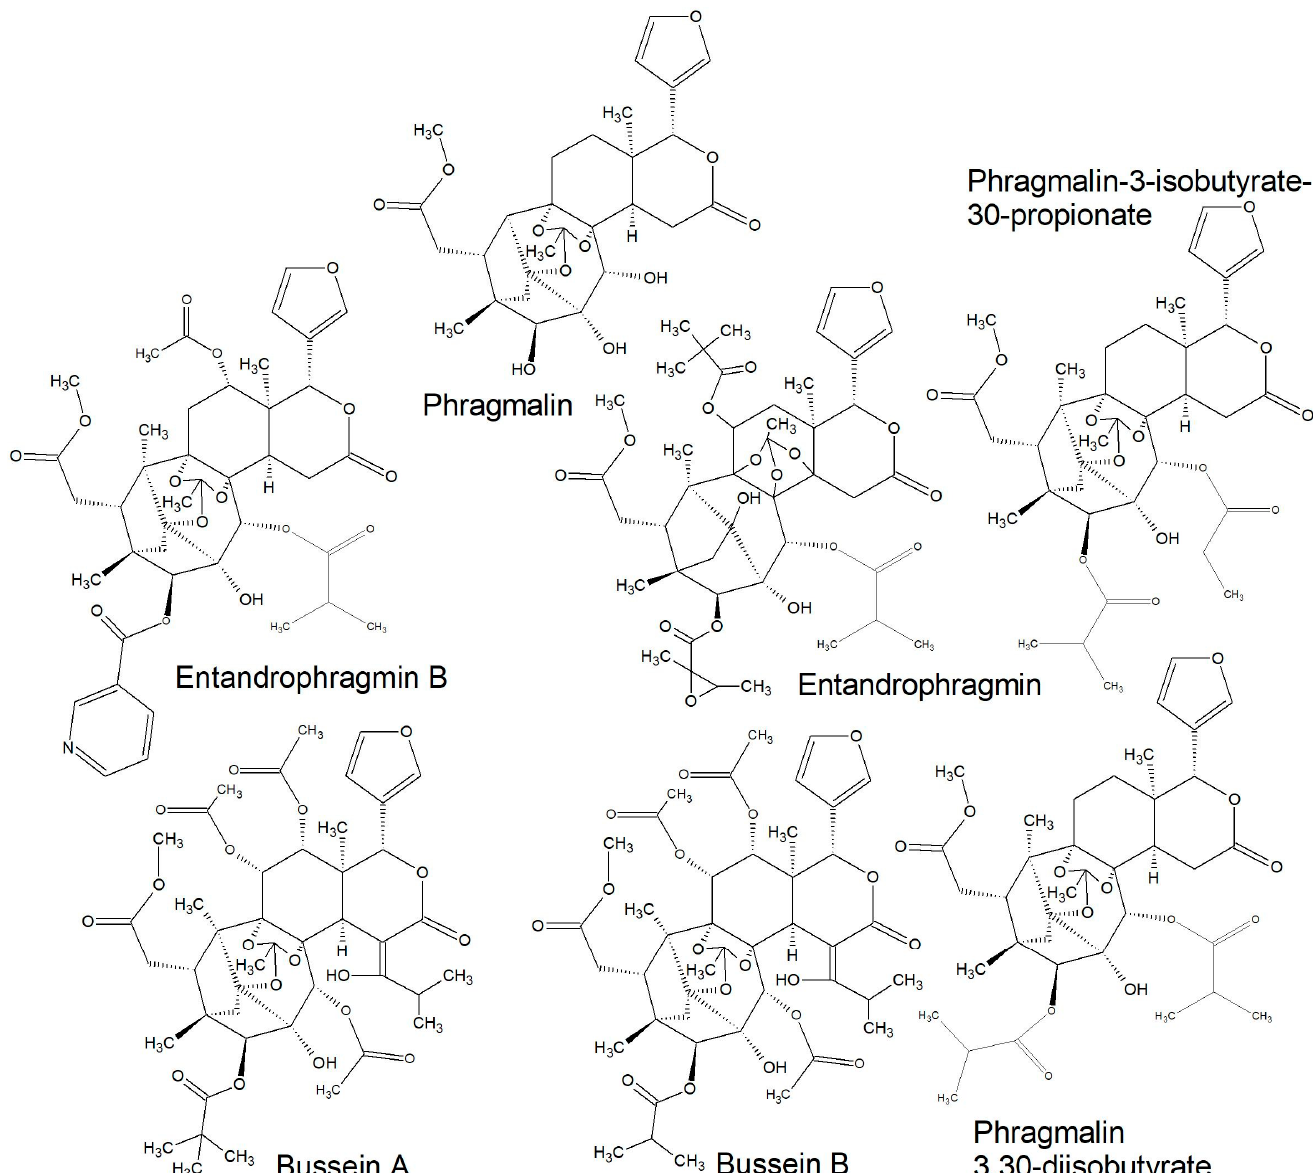
Figure 12. Phragmalin, phragmin, and bussein series of limonoids reported from South African Meliaceae [113,116].